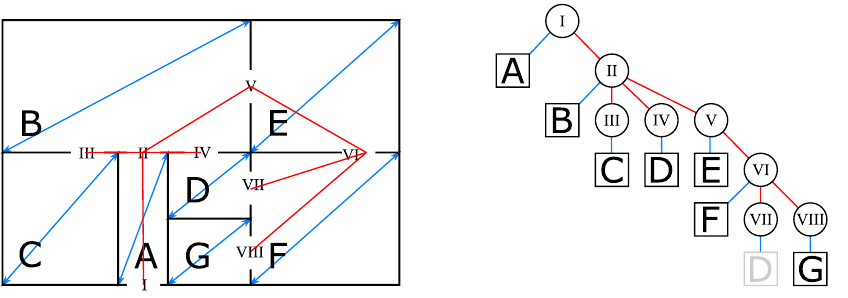
Figure 8. This example illustrates the resulting connection graph ( right ), a so-called minimum- spanning tree, for a floor plan ( left ) on which all rooms must be contained (i.e., accessible) and whose escape routes must not exceed a limit value in length. The edges in the graph correspond to geometric lengths in the model, so that the escape route results as a direct edge sum.